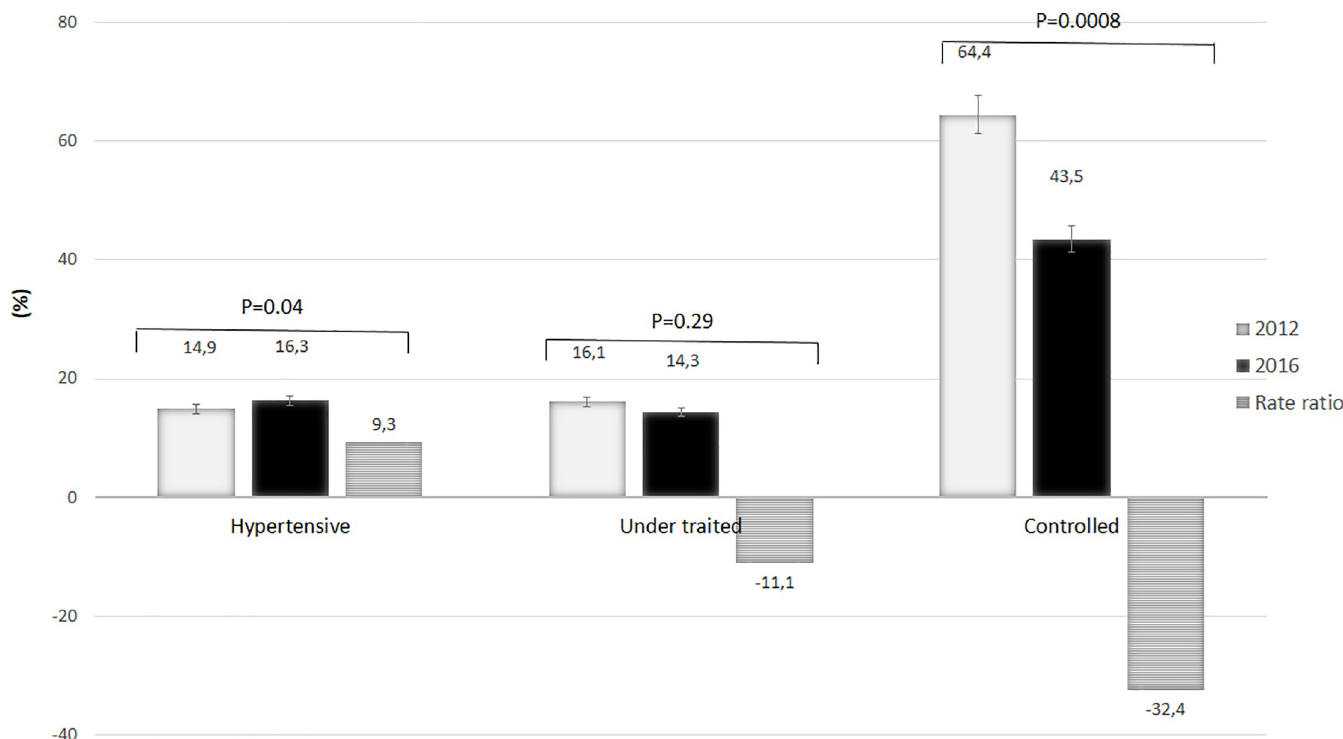
Fig 5. The levels of treatment and control of hypertension between 2012 and